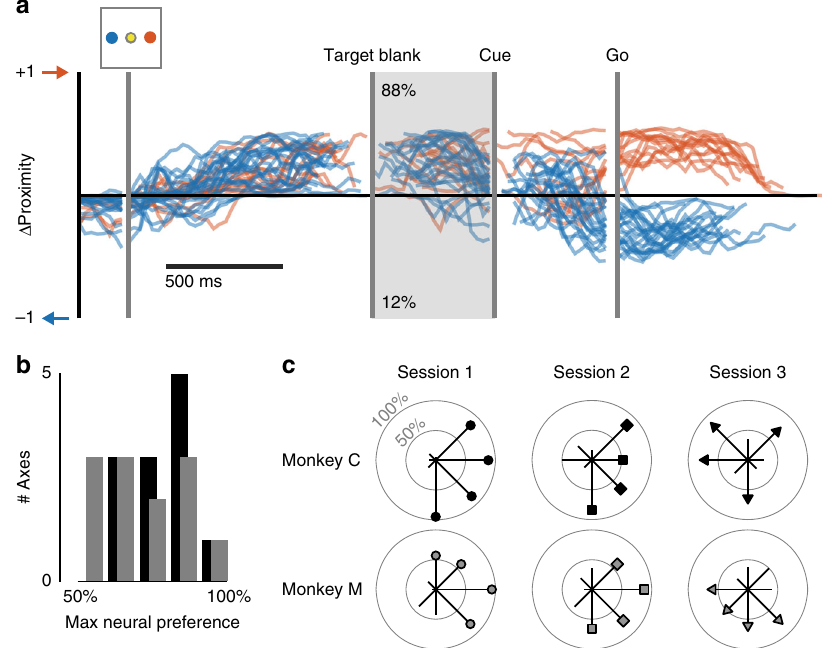
Fig. 7 Preferential reach planning in PMd during two-target trials. a Δ Proximity traces for all left/right trials in an example session (monkey C, session 1). Blue traces indicate those for which the monkey was cued to the left. Red traces indicate trials cued to the right. During the Target Blank epoch, 88% of activity indicated a rightward reach plan. Activity prior to Target Blank epoch is aligned to Target On. Activity during the Target Blank epoch is aligned to Cue appearance. Activity after Cue appearance is aligned to the Go cue. b Distribution of neural preferences across target axes from all sessions (black, monkey C; gray, monkey M). c Neural preferences across sessions. For each axis, radial length represents the observed